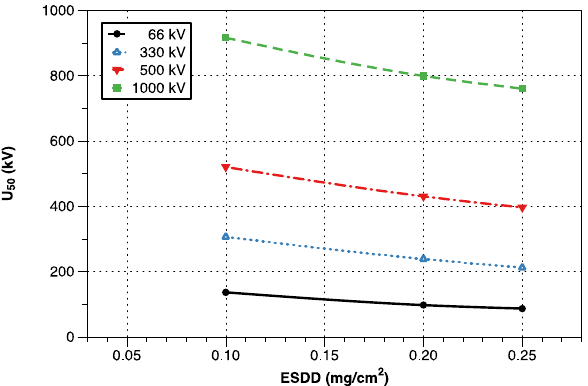
Figure 3. Pollution flashover test results of composite crossarm insulators with different voltage grades.